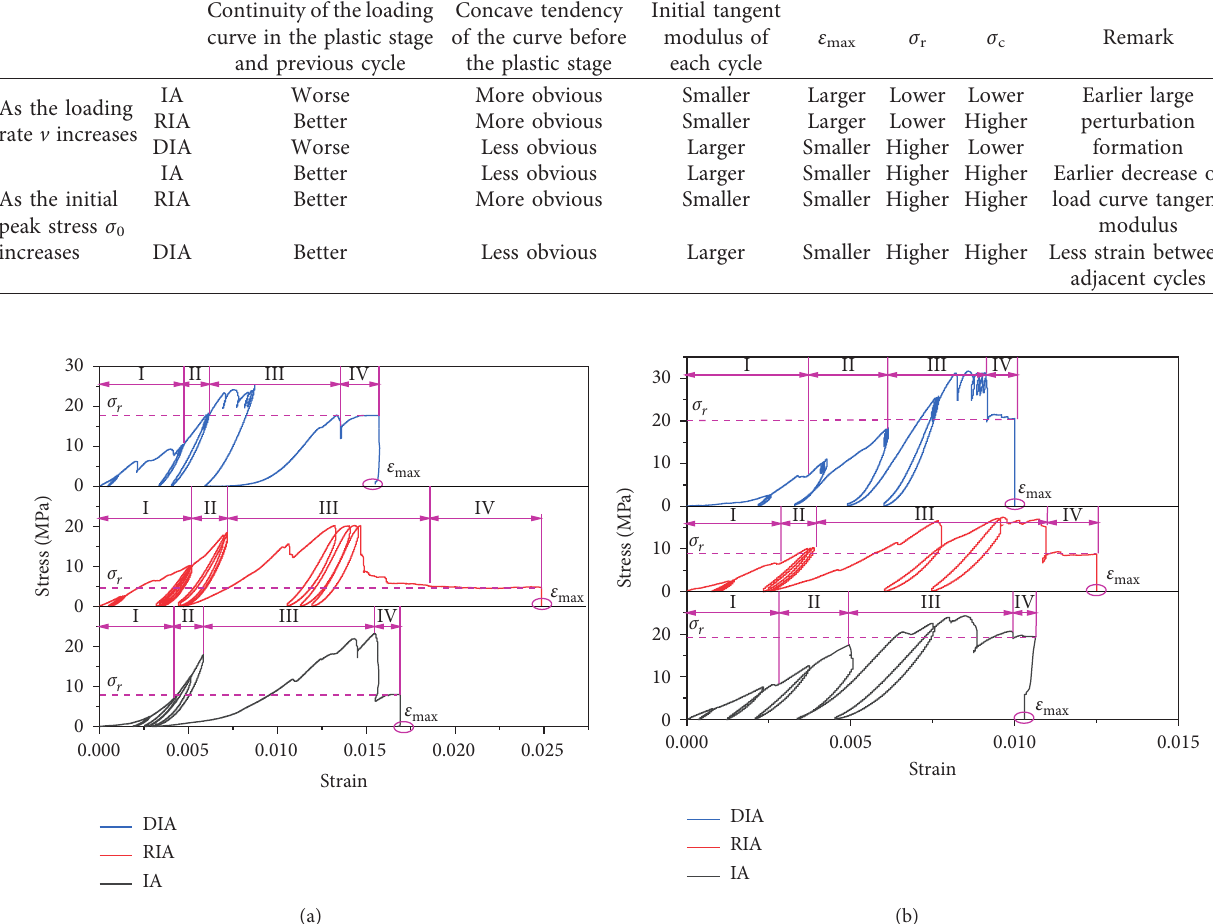
Figure 3: Experimental instrument flowchart. Stress-strain curves of the rock for different loading and unloading methods: (a) v � 0.2mm/ min, σ 0 � 2.5MPa; (b) v � 0.15mm/min, σ 0 � 2.5 MPa. I, compression stage; II, linear-elastic stage; III, plastic stage; and IV, softening